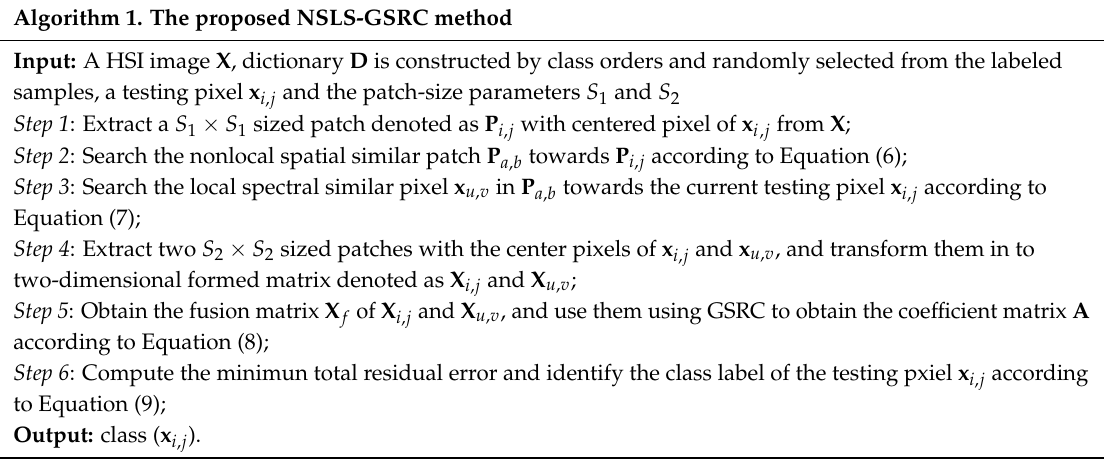
Algorithm 1. The proposed NSLS-GSRC